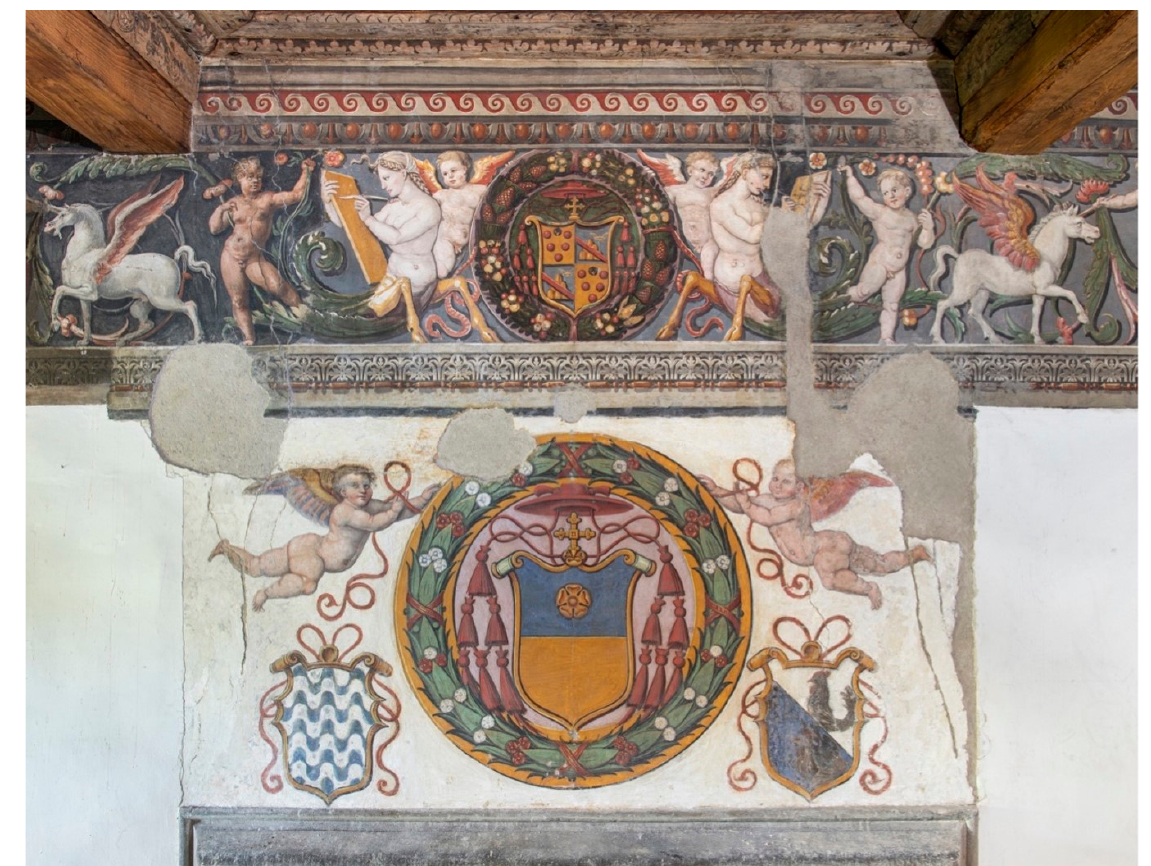
Figure 18. The wall paintings after the restoration. Photograph by Gaetano Alfano.